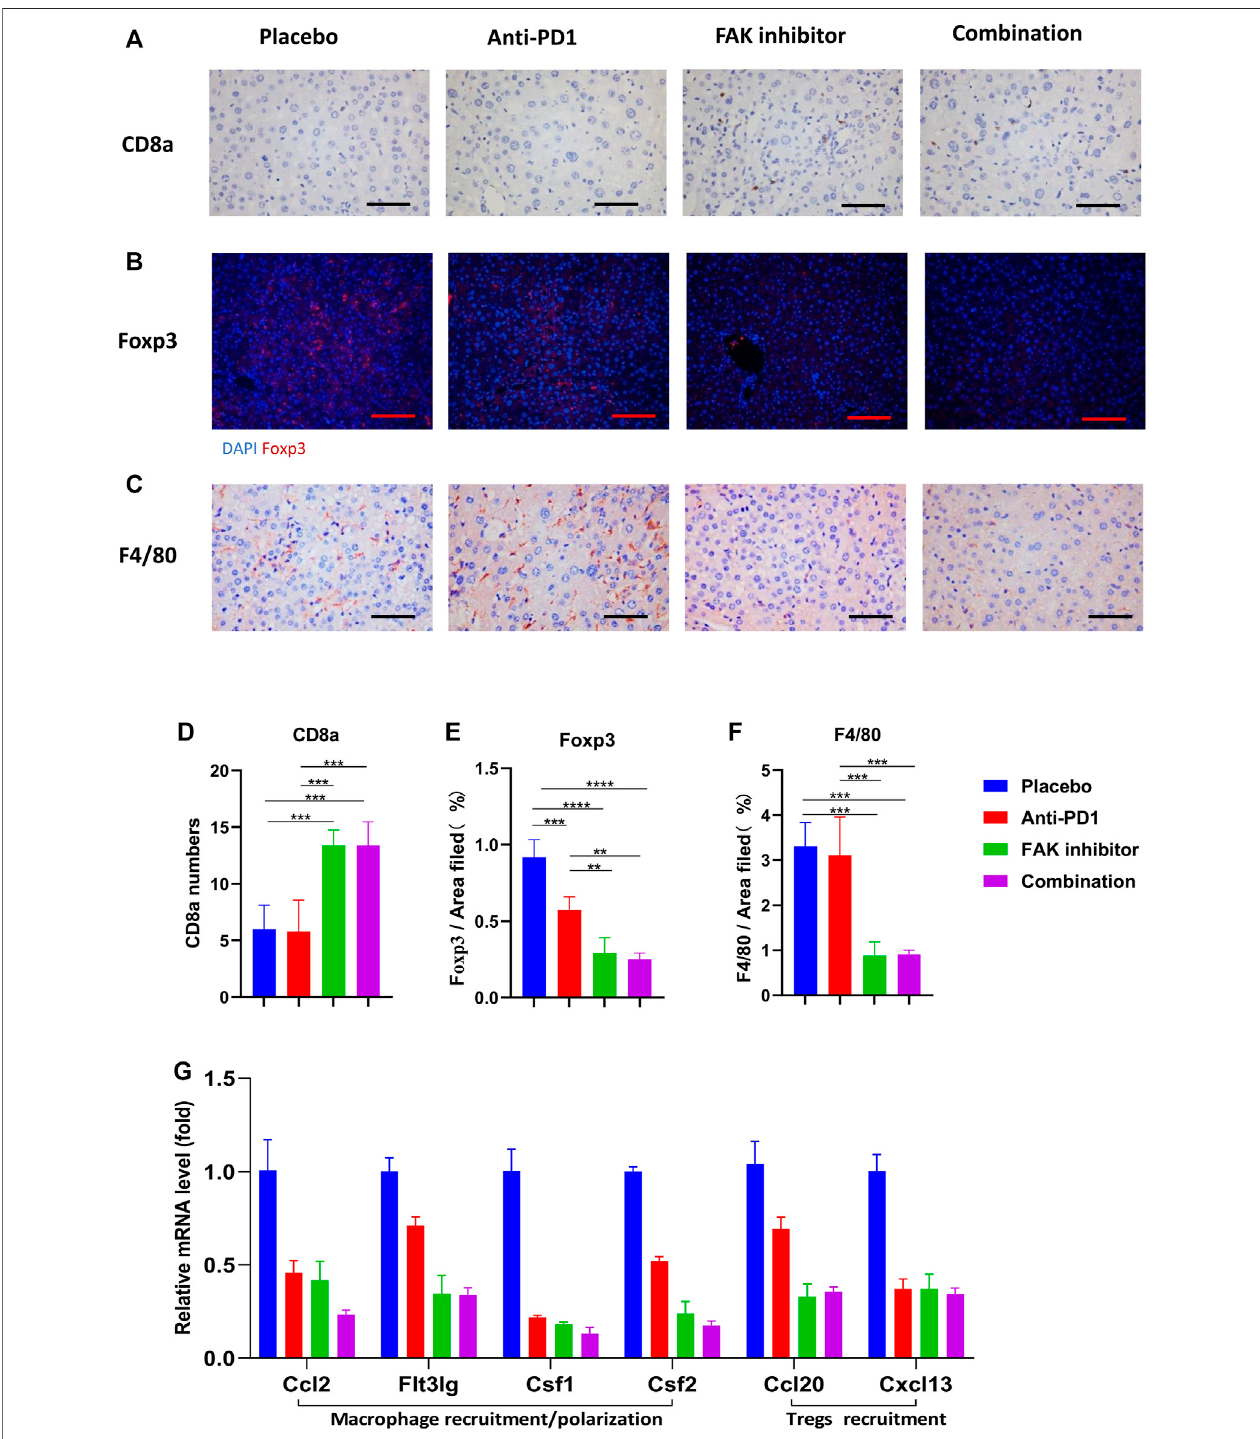
FIGURE 5 | FAK inhibition improved the immune microenvironment of HCC in mice (A) CD8a immunohistochemistry on HCC tissues of mice in each group (scale bars, 100 μ m). (B) Foxp3 immuno fl uorescence on HCC tissues of mice in each group (scale bars, 200 μ m). (C) F4/80 immunohistochemistry on HCC tissues of mice in eachgroup(scalebars,100 μ m). (D) ThenumberofCD8apositivecellsinonHCCofmice( n (cid:1) 5mice/group). (E) QuantitativeanalysisofFoxp3positiveareaper fi eldby ImageJ( n (cid:1) 4mice/group). (F) QuantitativeanalysisofF4/80positiveareaper fi eldbyImageJ( n (cid:1) 4mice/group).Signi fi canceidenti fi cation:ns, p ≥ 0.05;*, p < 0.05; **, p < 0.01; ***, p < 0.001. (G) The mRNA expressions of macrophage recruitment/polarization factors (Ccl2, Flt3lg, Csf1, Csf2) and Tregs recruitment factors (Ccl20, Cxcl13) in HCC tissues of mice detected by q-PCR ( n (cid:1) 3 mice/group).